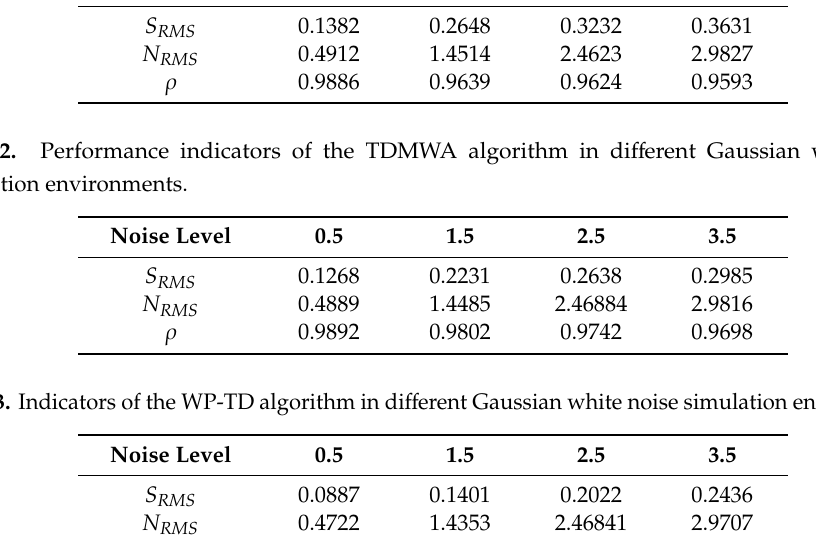
Table 2. Performance indicators of the TDMWA algorithm in different Gaussian white noise simulation environments.